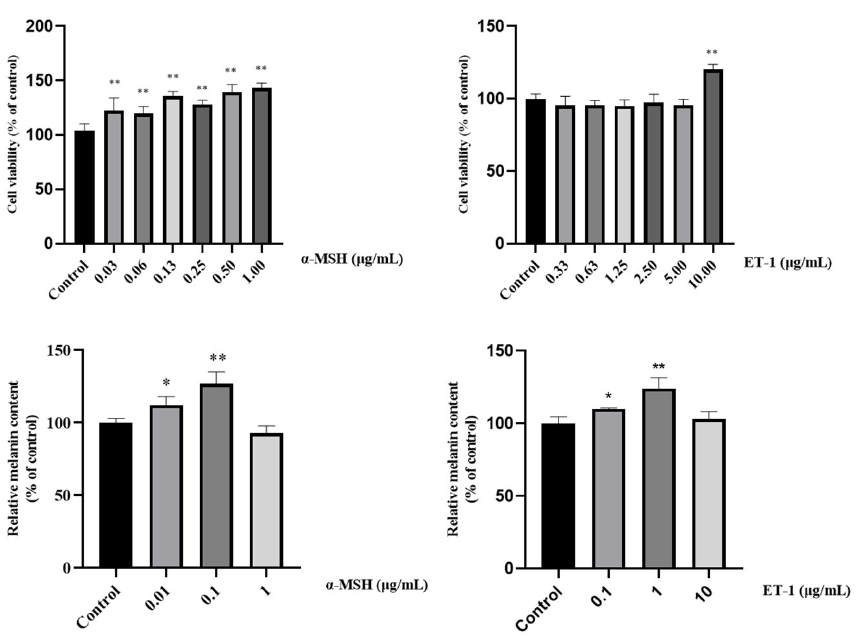
Figure 1. Melanoma cells (MNT-1) viability and melanin content in the presence of different concentrations of Endothelin-1 (ET-1) and alpha-melanocyte-stimulating hormone ( α -MSH) (* p < 0.05; ** p < 0.01 vs. control. t test, n ≥ 3).